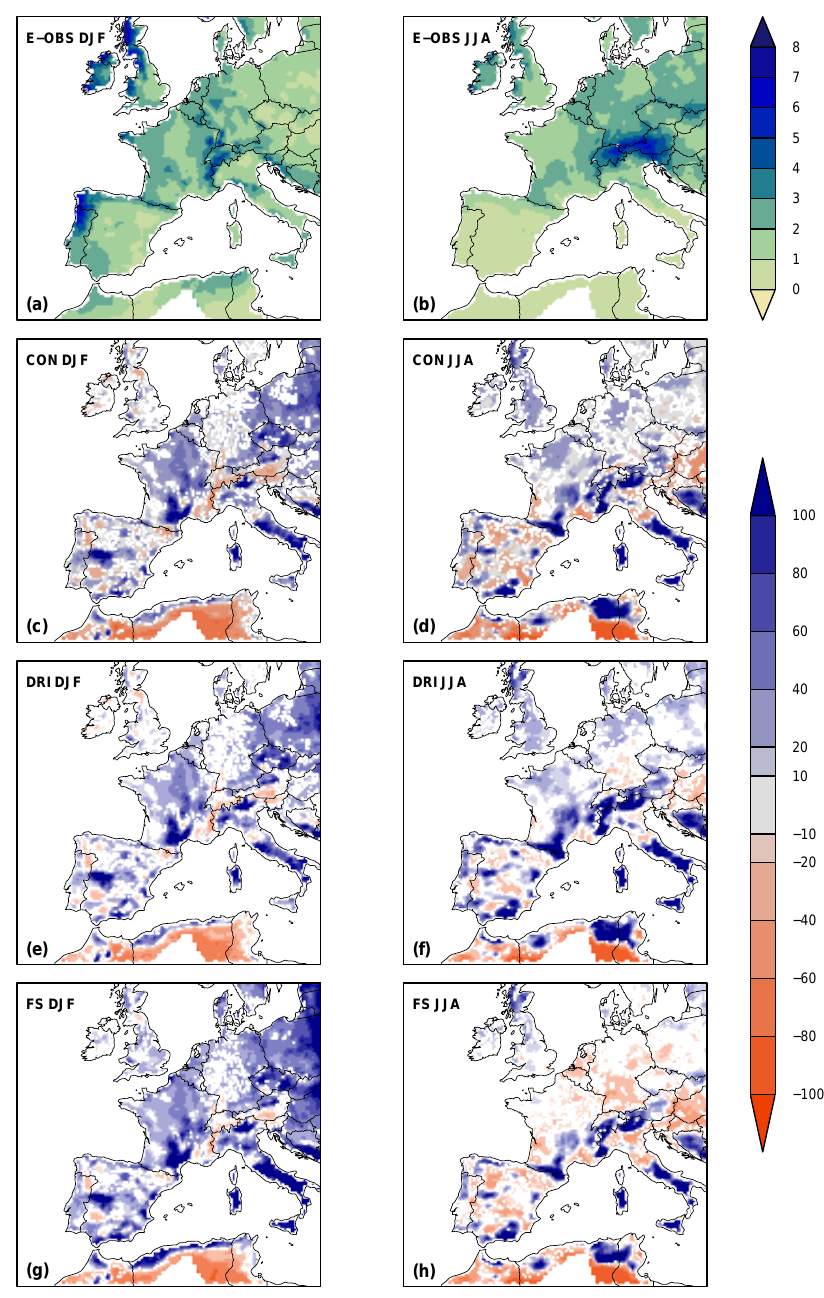
Figure 4. Daily accumulated precipitation (mmday − 1 ) for E-OBS DJF (a) and JJA (b) , and relative bias (%) of the model with E-OBS for CON DJF (c) and JJA (d) , for DRI DJF (e) and JJA (f) and for FS DJF (g) and JJA (h) , all at a 20km horizontal resolution for a 10-year period from 1991 to 2000. Only the significant biases are shown, using the F test at a 5% level, and non-significant biases are shown in